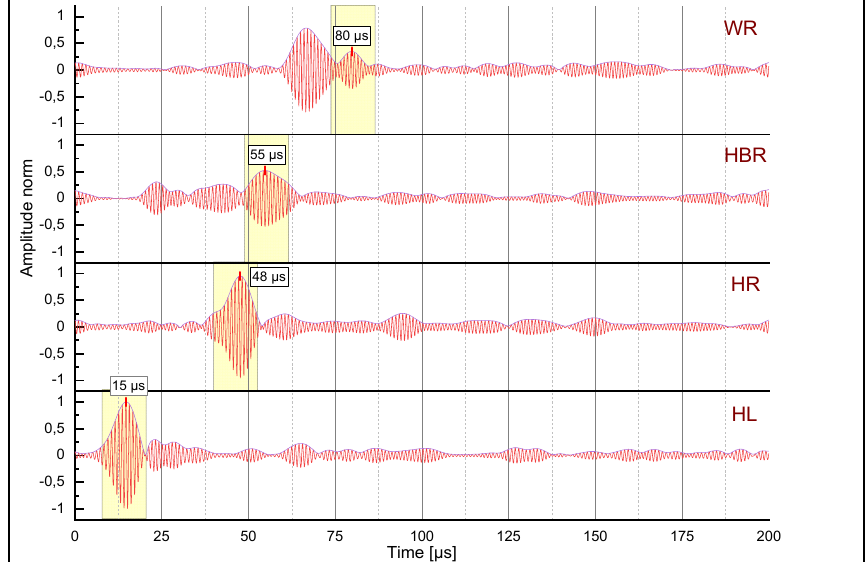
Figure 15. Signals measured along rail circumferential positions (HL, HR, HBR, WR) on the undam- aged rail, normalized with respect to the peak amplitude at position HL.